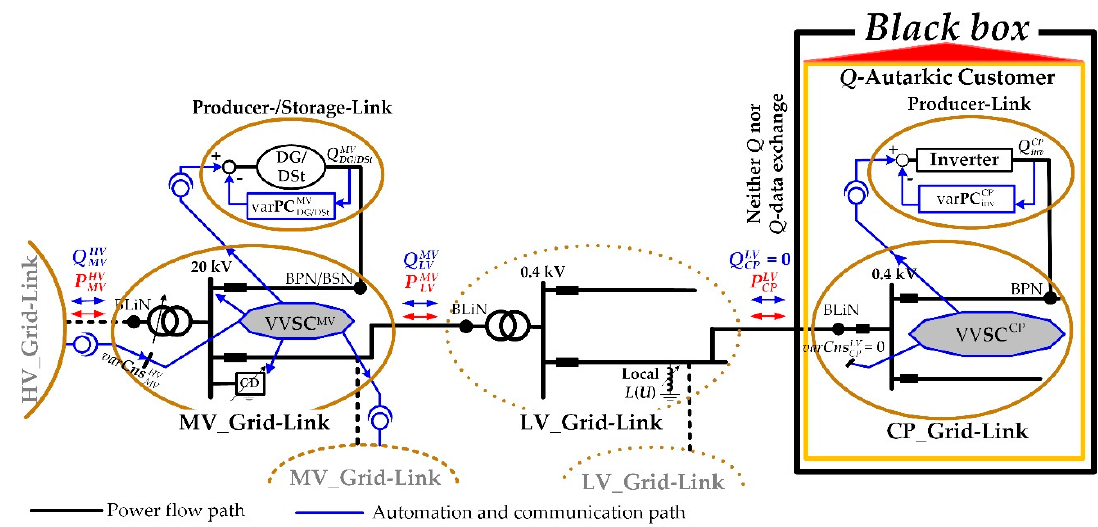
Figure 16. The most suitable setup of the VVC chain for a distribution grid with the highest PV share operated by one DSO.